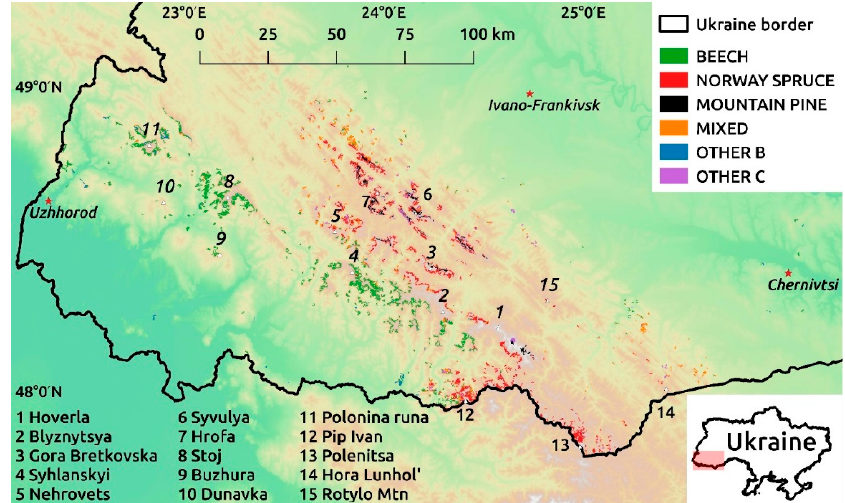
Figure 1. Map of study area showing old-growth forest (OGF) areas identified through surveys conducted by WWF. Elevation is shown as background colour and ranges from 100 m (light green) to 2060 m (orange). Solid colours show the dominant tree species within OGF. Inset map shows location of study area within Ukraine. Numbers identify important mountain peaks. Mixed OGF consists of two or more species with at least 20% abundance. “Other C” and “Other B” are non-mixed conifer and broadleaved OGFs respectively that are comprised of species other than beech, Norway spruce or mountain